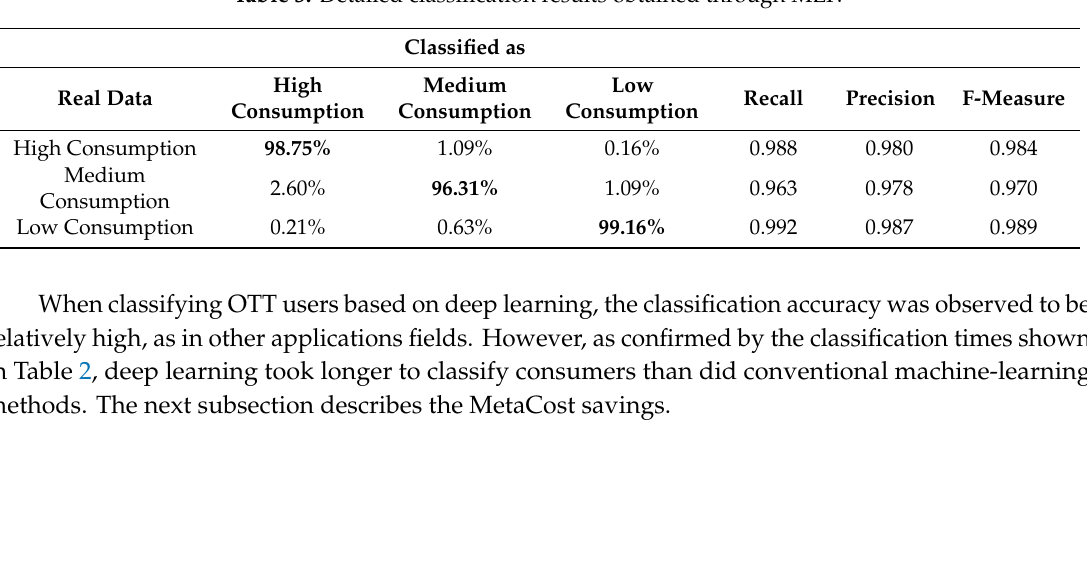
Table 3. Detailed classification results obtained through